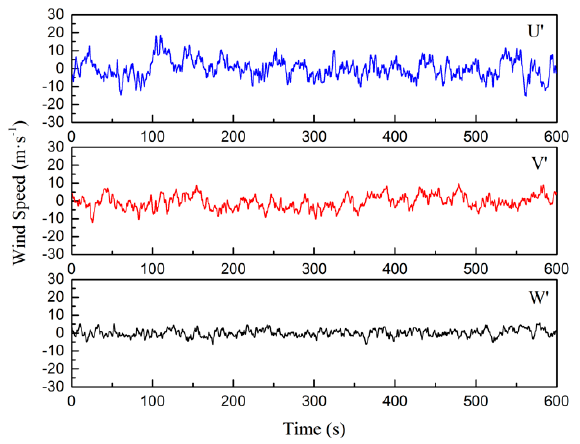
Figure 5. Fluctuating wind speed at hub height.